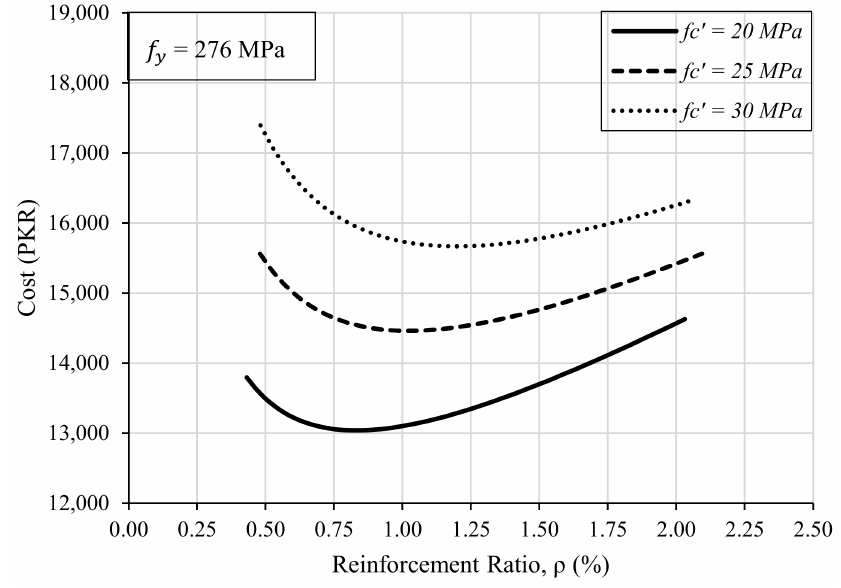
Figure 7. Effect of Compressive Strength of Concrete on Steel